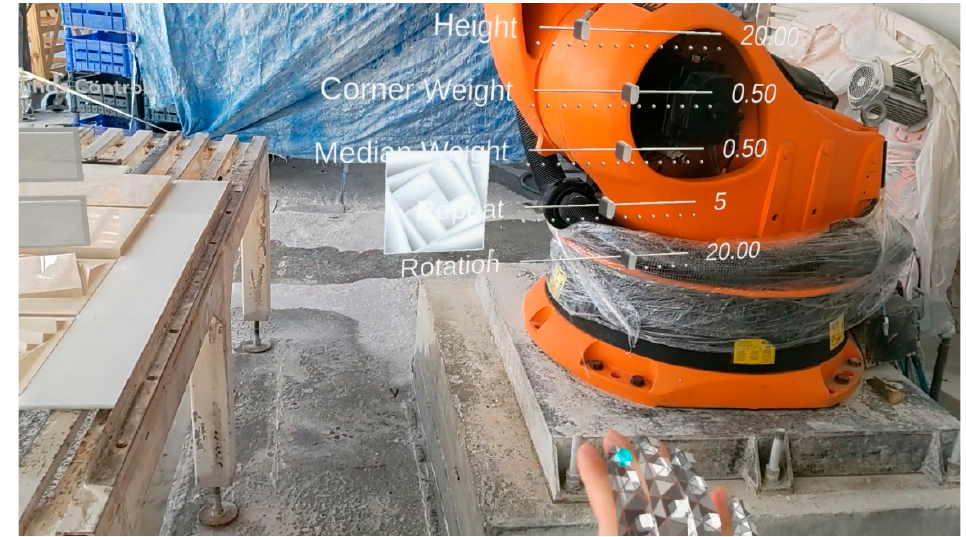
Figure 16. Interactive parametric design and interactive robotic fabrication controlled with the mixed-reality device in the production phase.